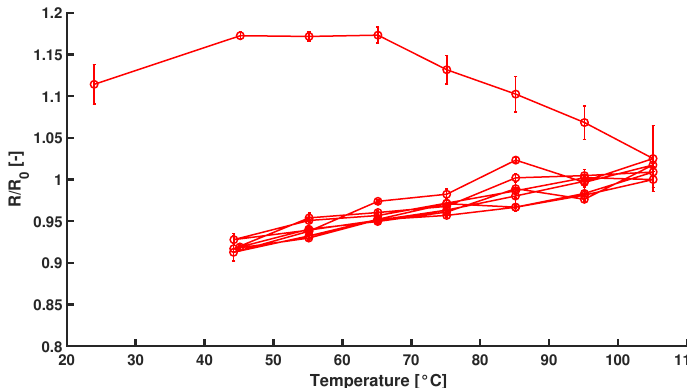
Figure A2. Thermal annealing of an evaporated 100nm Au layer.